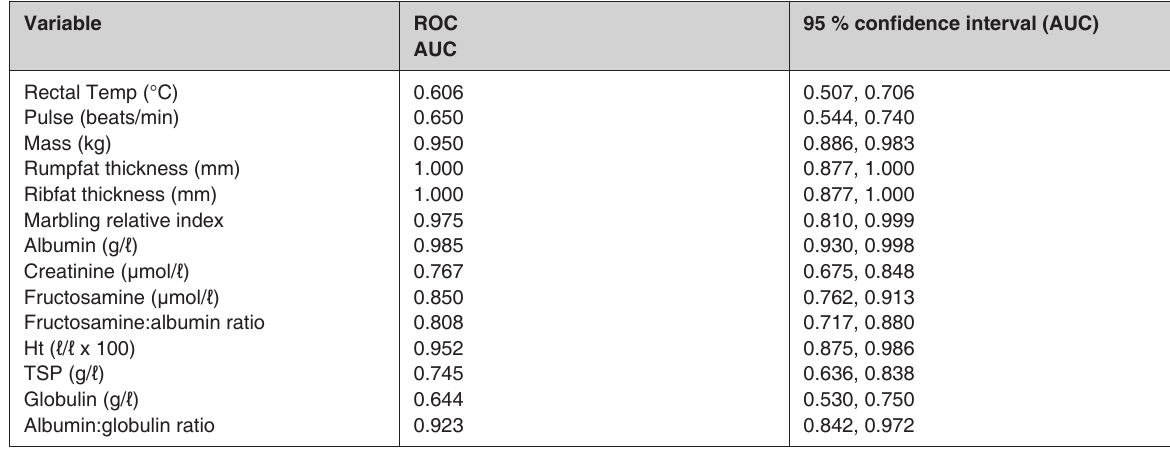
TABLE 2 Area under the receiver operating characteristic (ROC) curve for all the variables where there was a significant difference in medians between undernourished and adequately nourished cattle